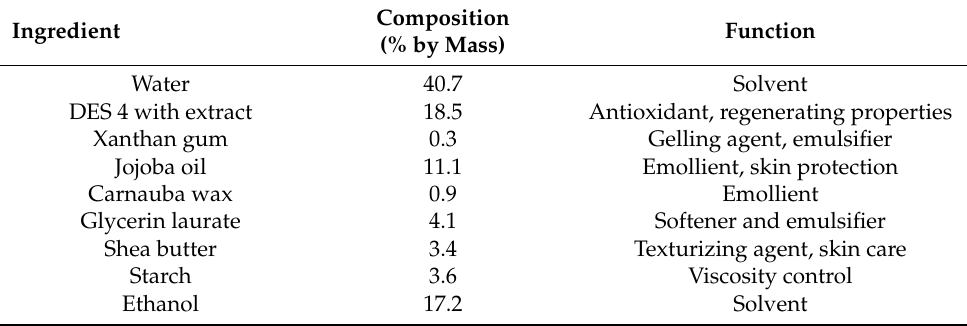
Table 12. Composition of moisturizing